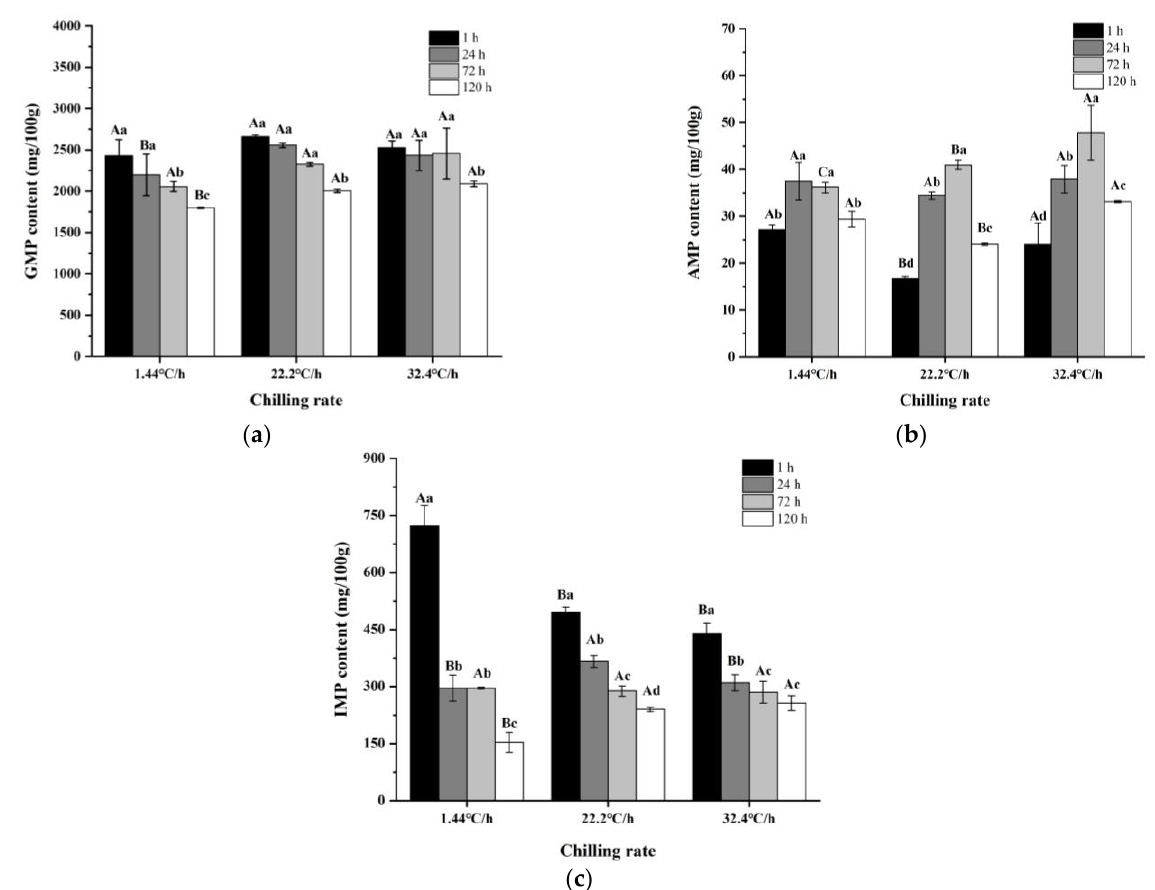
Figure 5. Contents of 5′-nucleotide in raw meat at different chilling rates during refrigeration. ( a ) Contents of 5′-guanylic acid (5’-GMP). ( b ) Contents of 5′-Adenosine monophosphate (5′-AMP). ( c ) Contents of 5′-inosine monophosphate (5’-IMP).